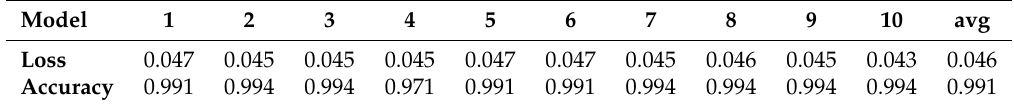
Table 6. Cross-validation of the BiLSTM + CNN